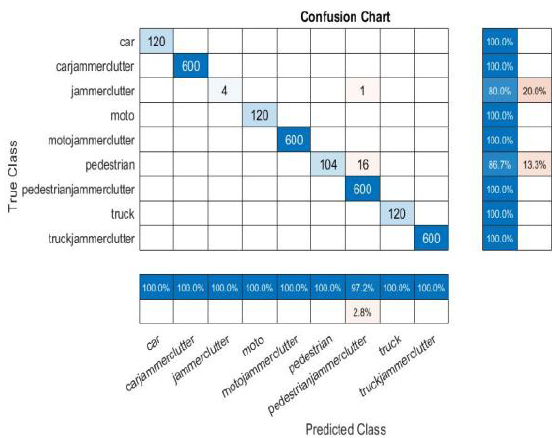
Fig. 10. Confusion chart for classification TABLE VIII. PERFORMANCE OF SVM FOR CLASSIFICATION AND NOISE REJECTION Architecture